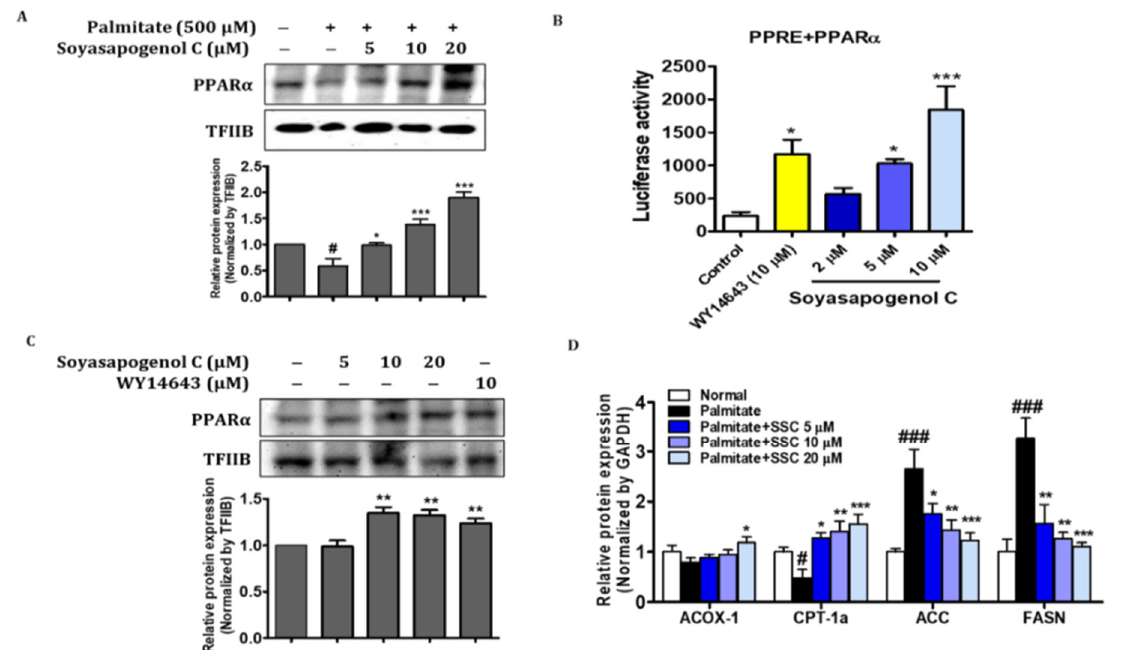
Figure 6. Effect of soyasapogenol C on AMPK activation in HepG2 cells. ( A ) Protein expression of phosphorylated AMPK was analyzed using Western blotting. ( B ) HepG2 cells were treated with palmitate (500 μ M) and/or soyasapogenol C (5, 10, and 20 μ M) for 24 h. Data are presented as the mean ± SEM of three independent expressions. ** p < 0.01 vs. normal; # p < 0.05, and *** p < 0.001 vs. palmitate ‐ treated.